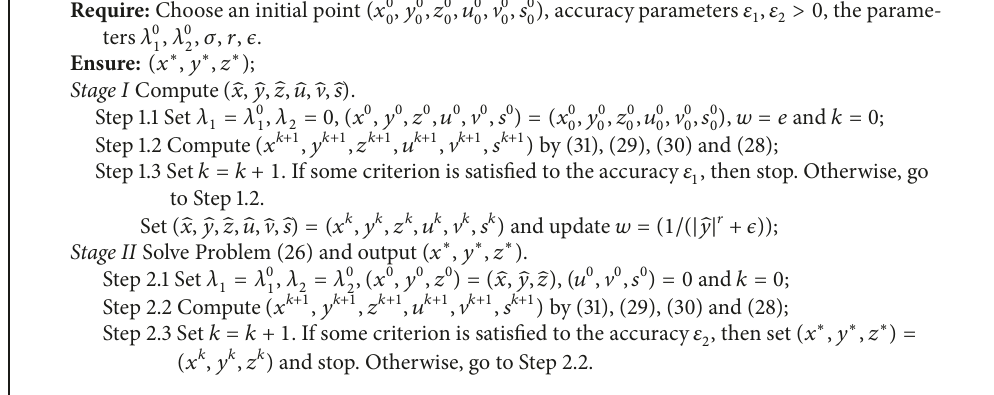
Algorithm 1: A two-stage alternating direction methods of multipliers